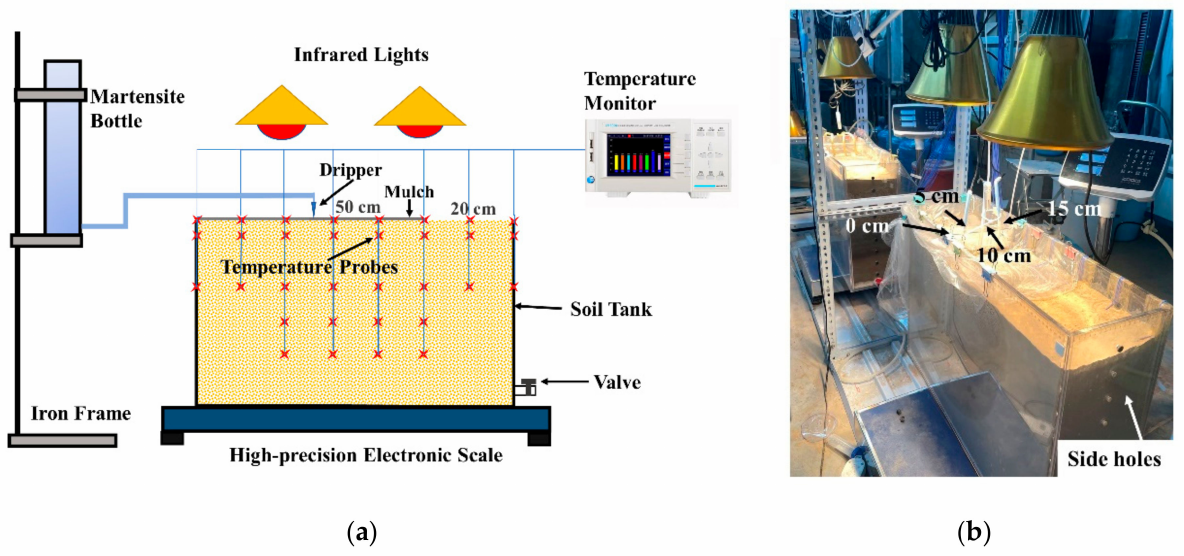
Figure 1. Layout of the mulched drip-irrigation system in the indoor soil tank: ( a ) Sketch map of design; ( b ) photograph of